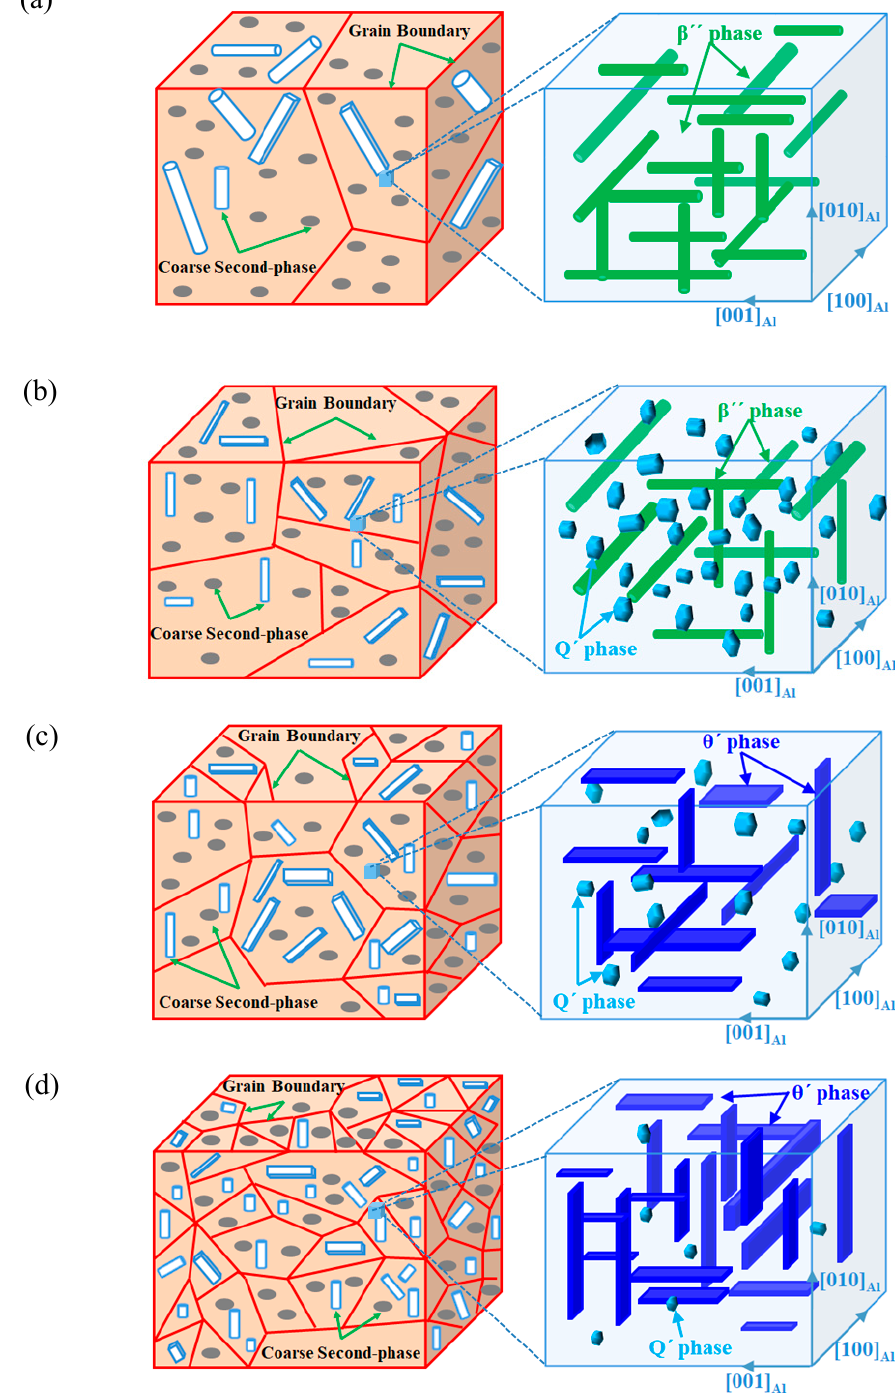
Figure 21. Schematic drawings illustrating the microstructure of the peak-aged four alloys ( a ) Alloy 1, ( b ) Alloy 2; ( c ) Alloy 3, and ( d ) Alloy 4.